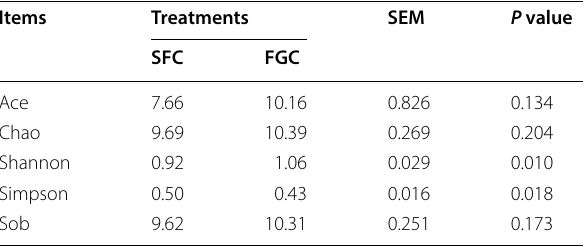
Table 2 Alpha diversity indices for species richness, abundance, and population diversity in the rumen bacterial communities in heifers fed different corn processed corn diet